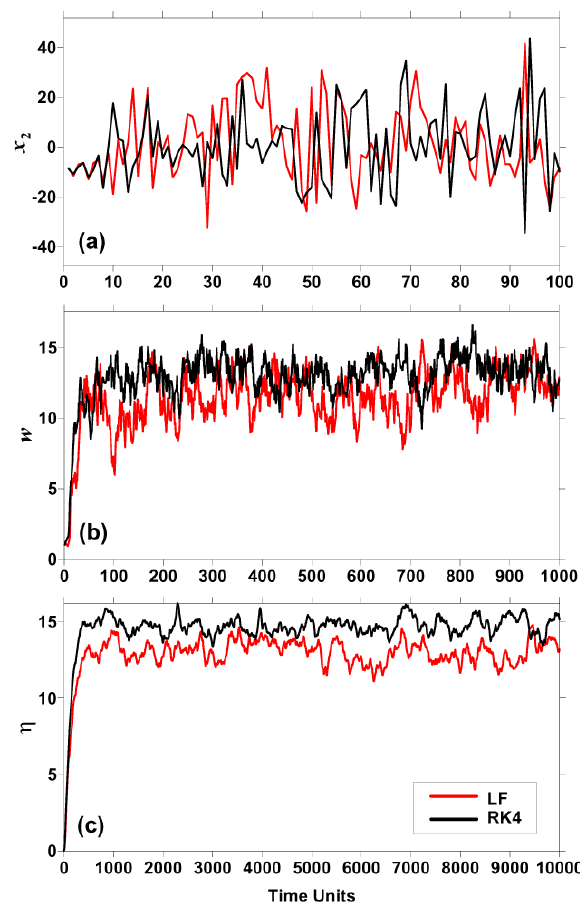
Fig. 1. Time series of (a) x 2 in the first 100TUs, (b) w in the first 10 3 TUs, and (c) η in 10 4 TUs derived from both the LF (red line) and the RK4 (black line) time-differencing schemes.